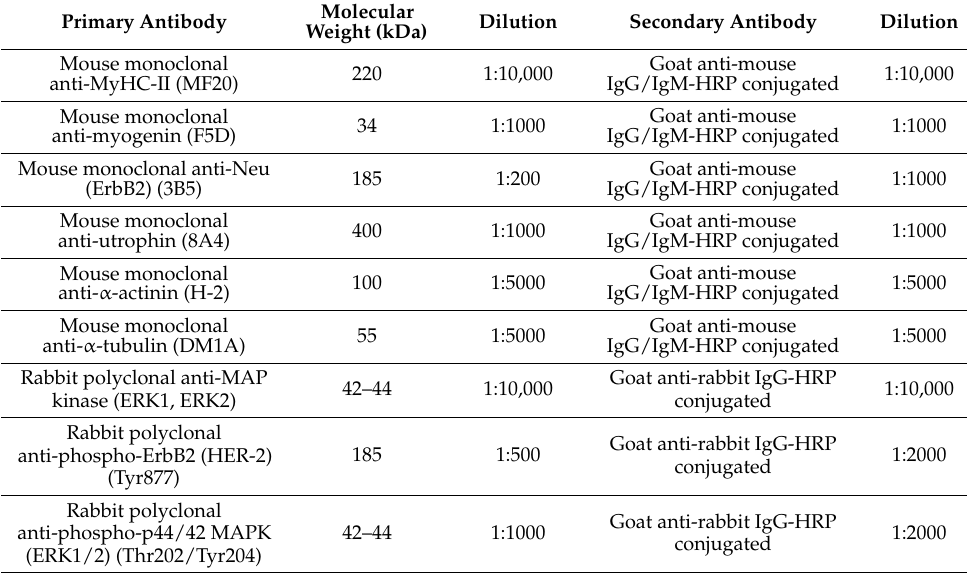
Table A2. List of primary and secondary antibodies used in Western